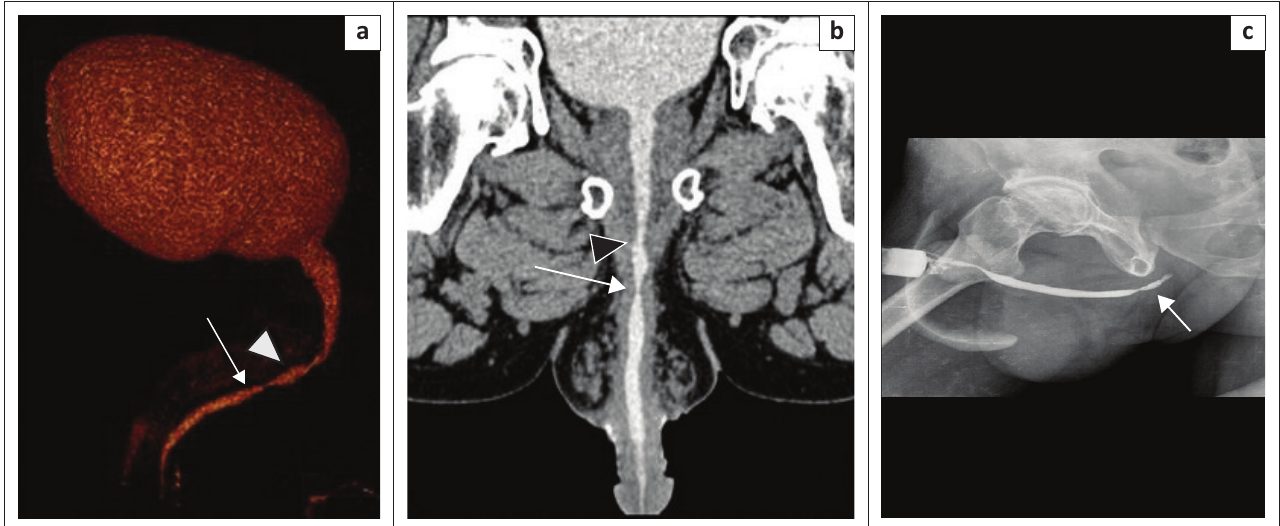
FIG URE 4: (a) Volume rendering technique image (multidetector computed tomographic urethrography [MDCTU]) showing two strictures, one at the penobulbar junction (arrow) and the other in the bulbar urethra (arrowhead). (b) Curved multiplanar reformatted image (MDCTU) of the same patient showing the two strictures. (c) Retrograde urethrography image of the same patient demonstrating the stricture at the penobulbar junction (arrow), with no distal passage of contrast into the posterior